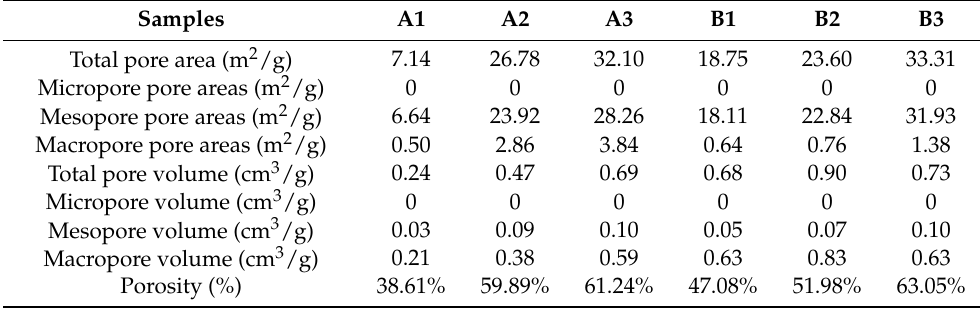
Table 1. Pore structural parameters of mudstone and coal specimens with distinct granule diameters from the MIP measurement.